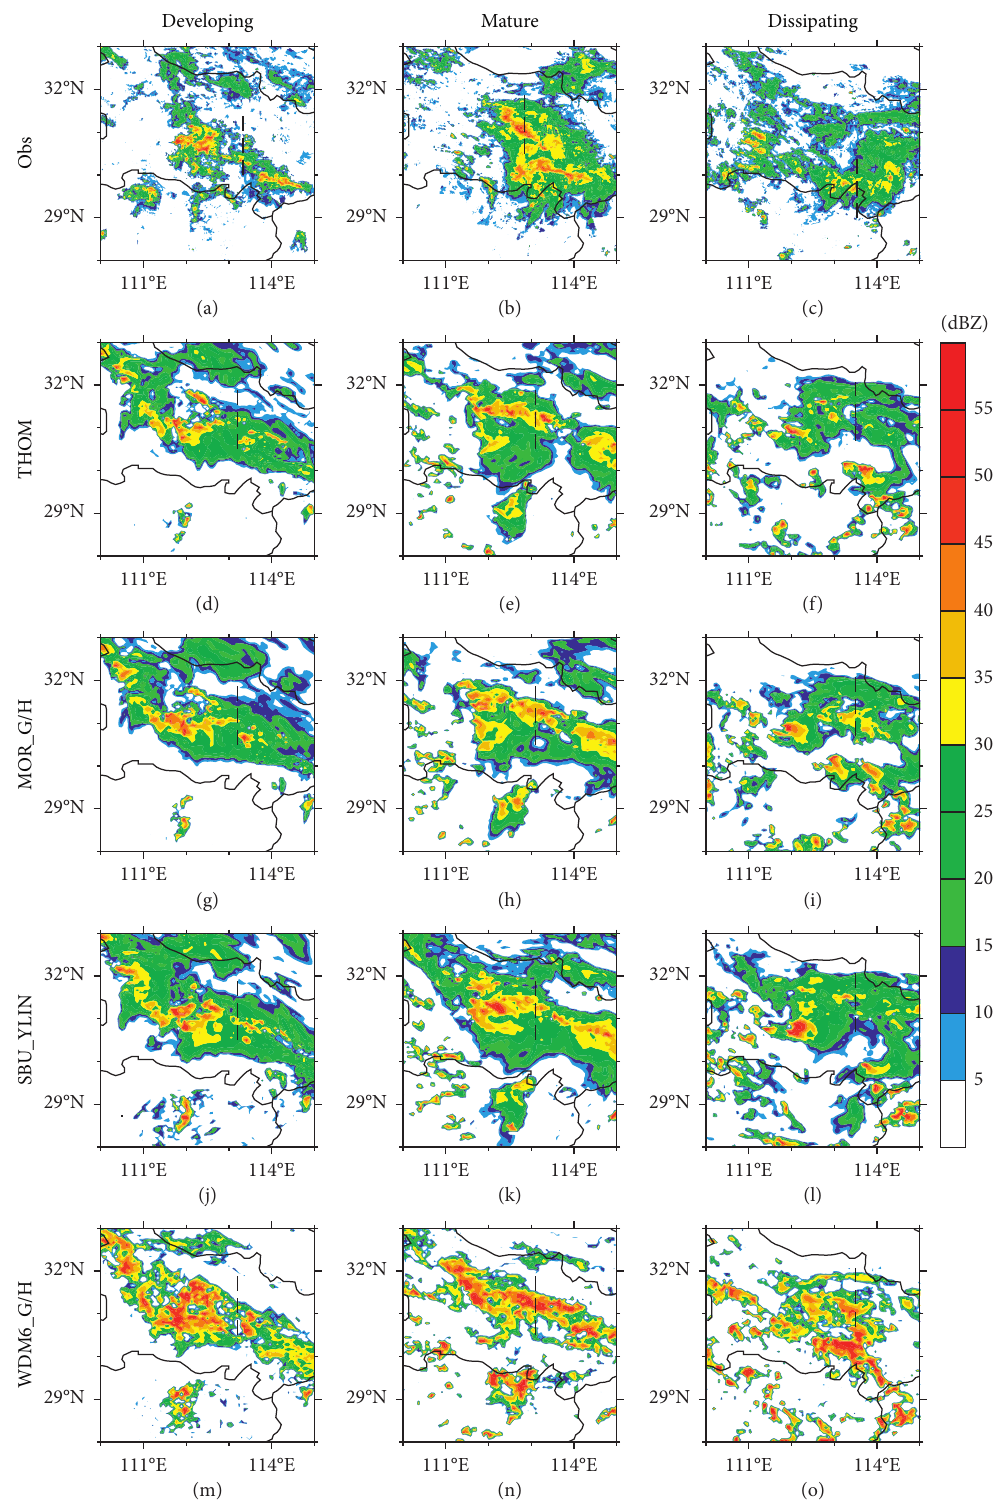
Figure 7: Comparisons of (a), (b), (c) radar reflectivity (Ze, dBZ) at 3km and modeled radar reflectivity of (d), (e), (f) THOM; (g), (h), (i) MOR_G/H; (j), (k), (l) SBU-YLIN; and (m), (n), (o) WDM6_G/H during developing (the first column), mature (the second column), and dissipating (the third column) stage. The black lines are used to define the cross section in Figure